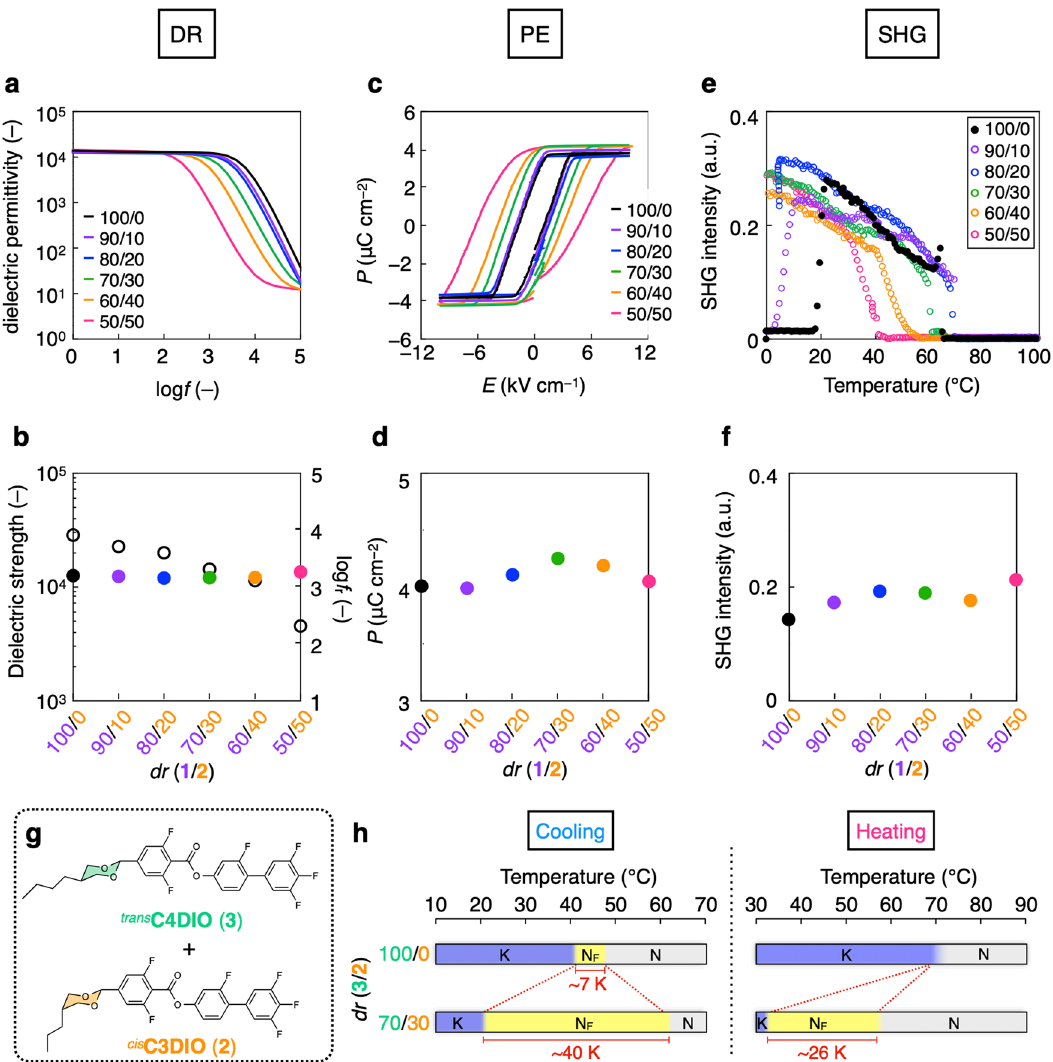
Fig. 5 Polarization behavior of the 1/2 mixture with various dr . a Dielectric spectra. b Dielectric strength and the corresponding relaxation frequency (log f r ) vs. dr ( T − T c = − 10 °C). c P - E hysteresis loops ( f = 200 Hz, V max = 10 kV cm − 1 ). d Polarization density vs. dr ( T − T c = − 10 °C). e Field-induced p - in/ p -out SHG at a 45° incident angle as a function of temperature (0.7 V μ m − 1 ). f The SHG intensity vs. dr ( T − T c = − 10 °C). Notes: LC-cell conditions: thickness of 13 μ m; silanized coated ITO electrode (5 × 10 mm) for dielectric and P - E hysteresis studies); thickness of 5 μ m; silanized coated baked-ITO electrode (4 × 5 mm) for SHG study. g Chemical structures of trans C4DIO ( 3 ) and cis C3DIO ( 2 ). h Temperature-dependent phase behaviors of the 3 / 2 mixture with dr = 100/70 (upper) and dr = 70/30 (bottom) on cooling and